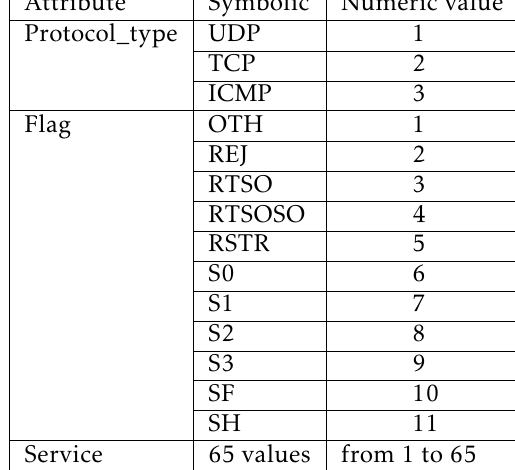
Figure 3. An example of an original vector x